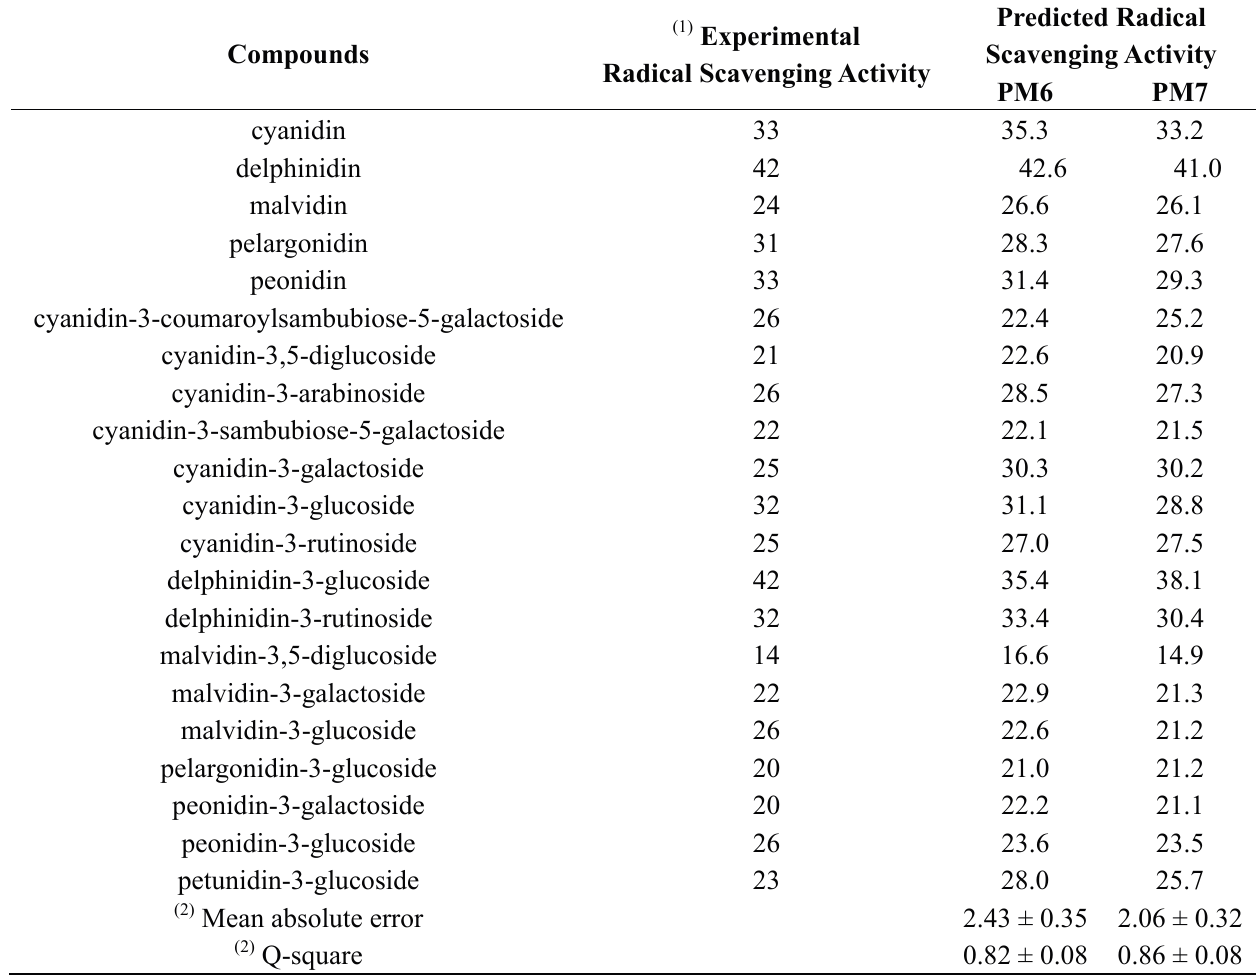
Table 3. Experimental and predicted DPPH radical scavenging activities.